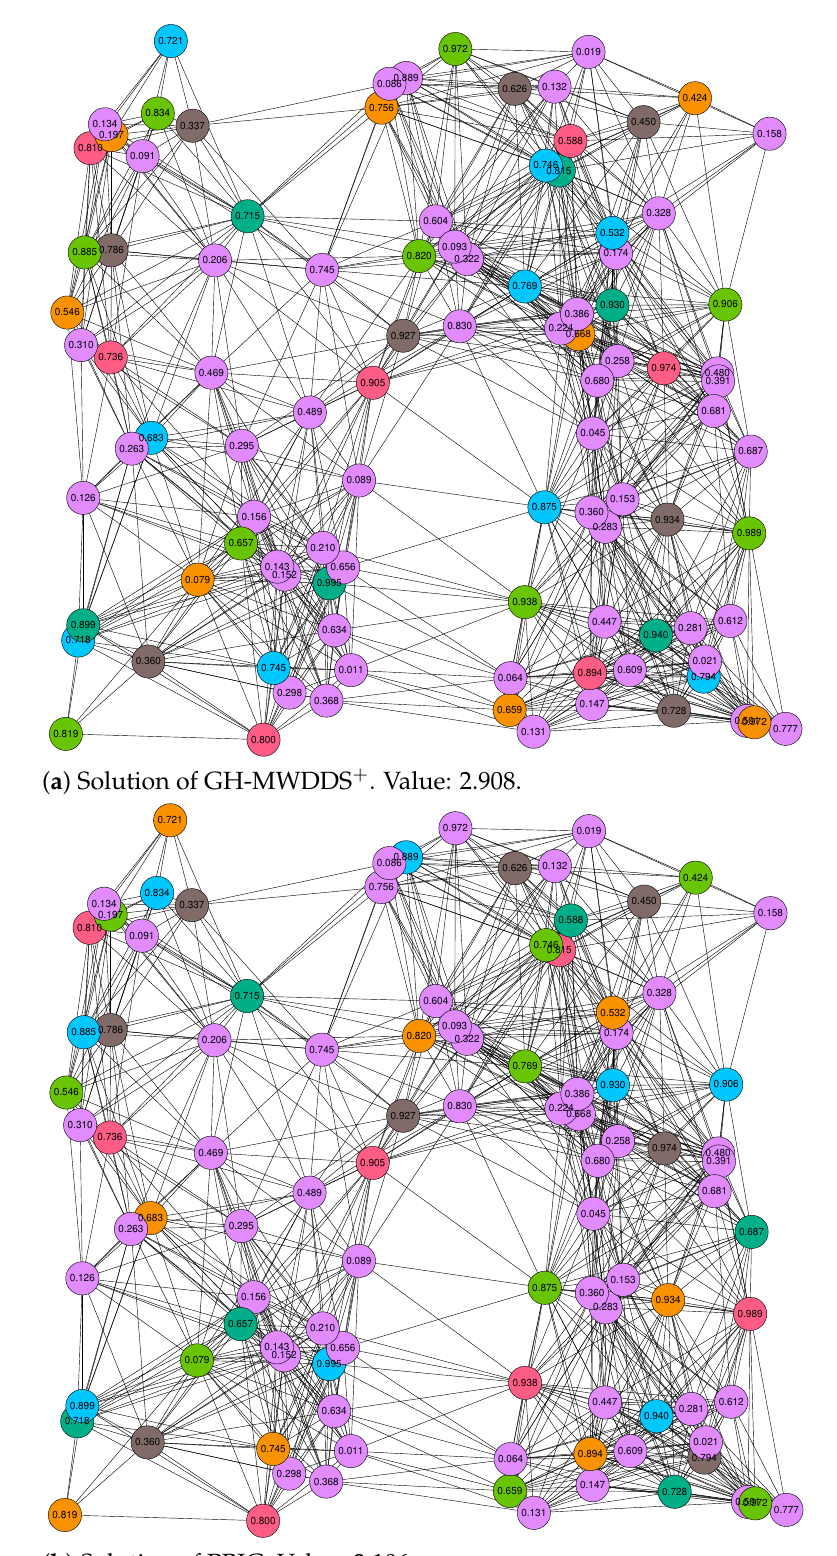
Figure 3. Solutions of GH-MWDDS + ( a ) and PBIG ( b ) for the first RGG graph with 100 nodes and a threshold value of r = 0.3. The lifetime of each node is provided as the node label. Moreover, the node colors indicate to which dominating set a node belongs. In both cases, the color purple indicates that the respective node is not chosen for a dominating